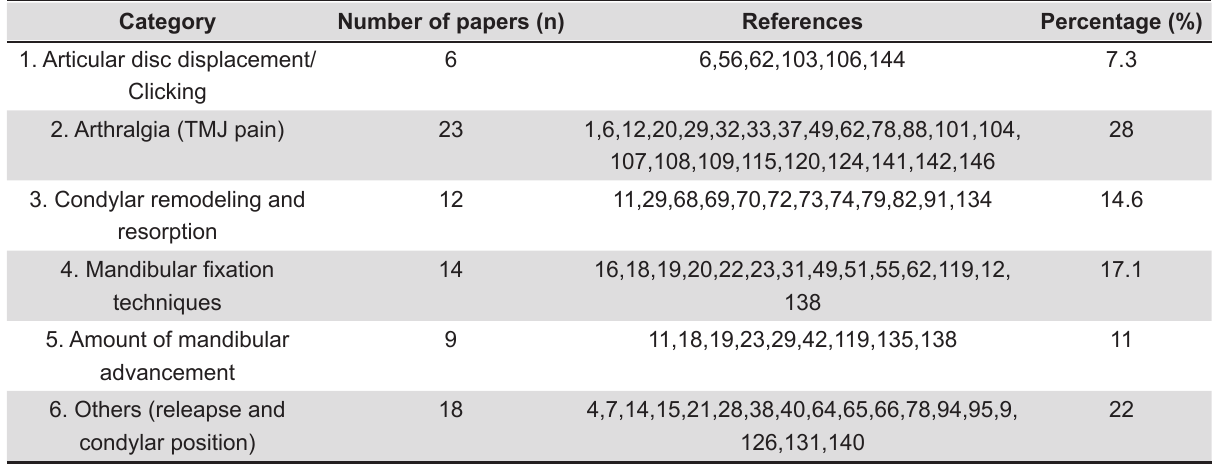
TMJ=temporomandibular